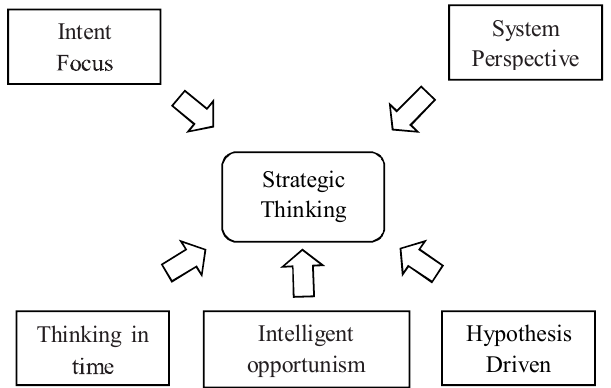
Fig. 1. The elements of strategic thinking (Liedtka,